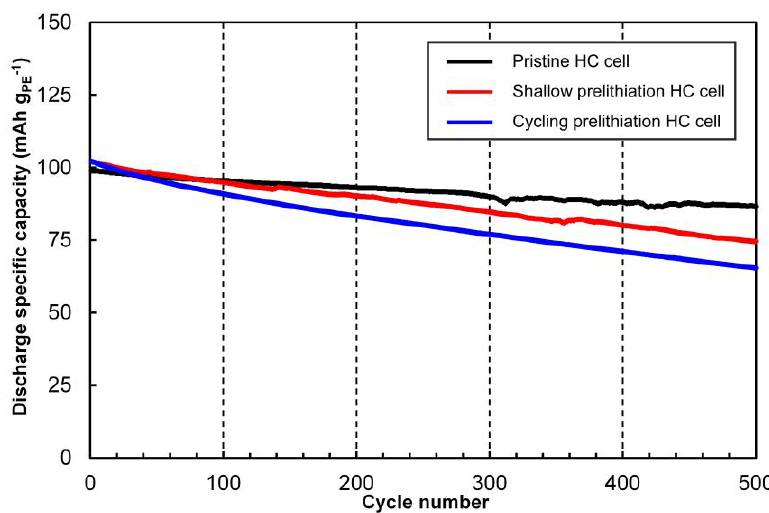
Figure 6. Cycling behavior of the full-cells with the pristine and prelithiated HC NEs in the cell voltage range of 2.5–4.2 V at 2 C-rate (340 mA g PE−1 ).